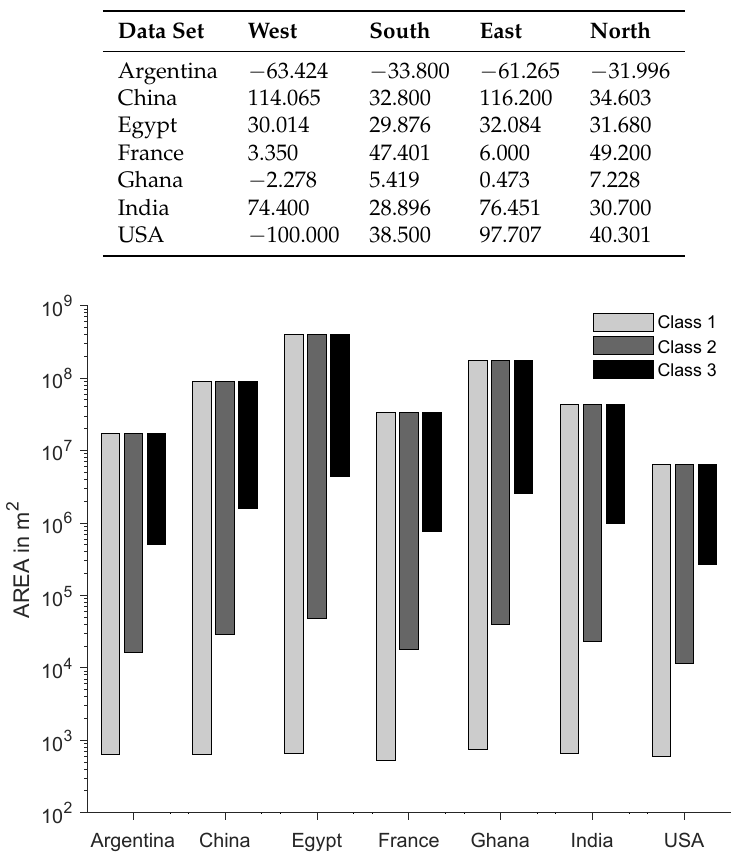
Figure A1. The columns represent the range of the settlement objects’ area for the different classes in each data